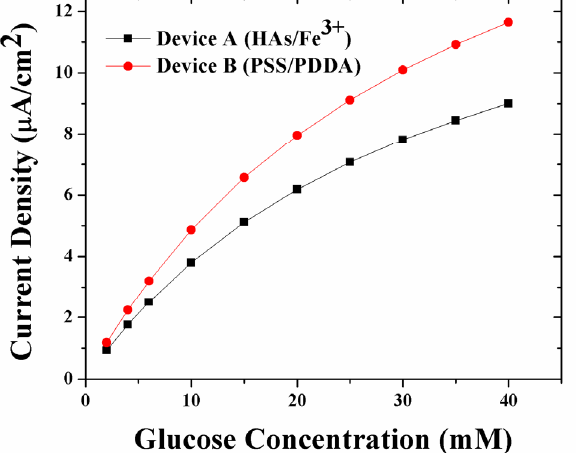
Figure 3. Simulated amperometric response of Device A (100 nm HAs/Fe 3+ ) and Device B (5 nm PSS/PDDA) employing 20 nm GO /PPD coating the electrode x